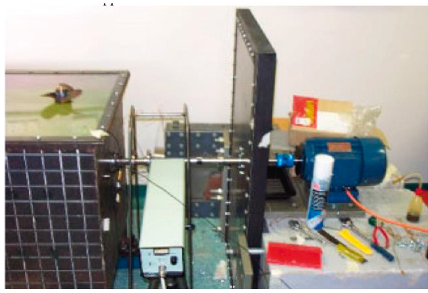
Figure 1: Test rig used by Pan [5].